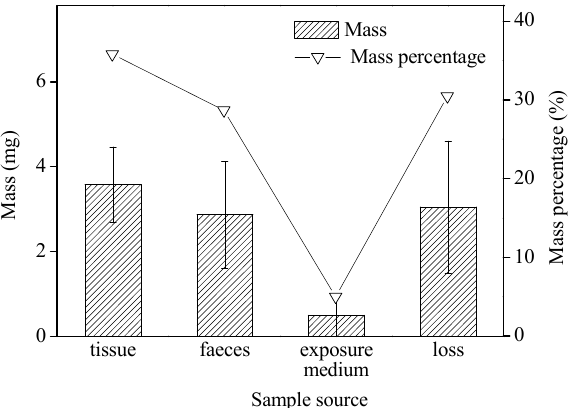
Figure 3. Microbead mass (mean ± standard deviation; n = 6) and its percentage in different media over 48-h exposure.